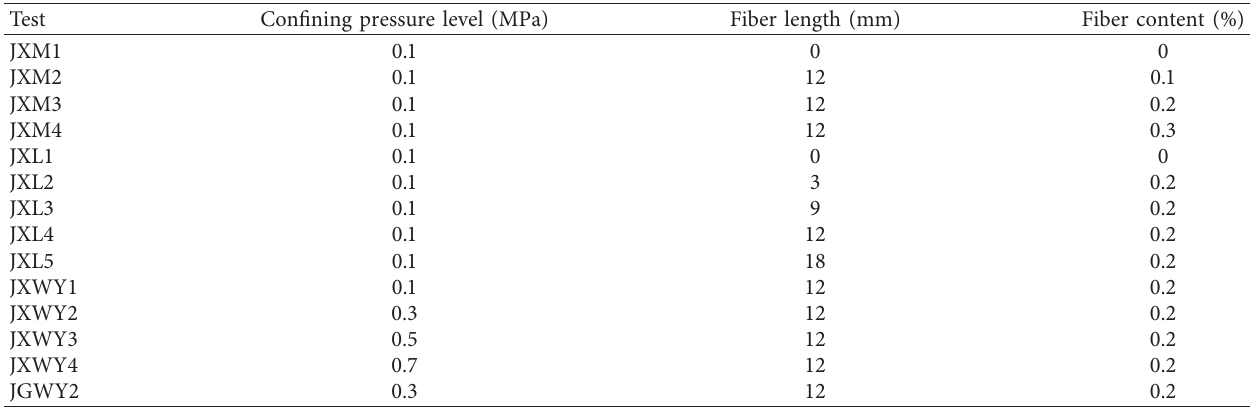
Table 3: Test procedures of fiber-reinforced soils.